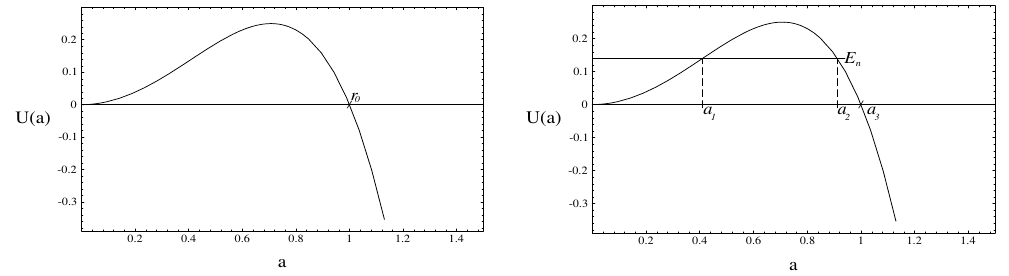
Figure 4. Left : The potential for the case of the birth of a closed universe from “nothing”, Equation (8). Right : The potential for the case of the birth of a universe with a nonzero energy, Equation